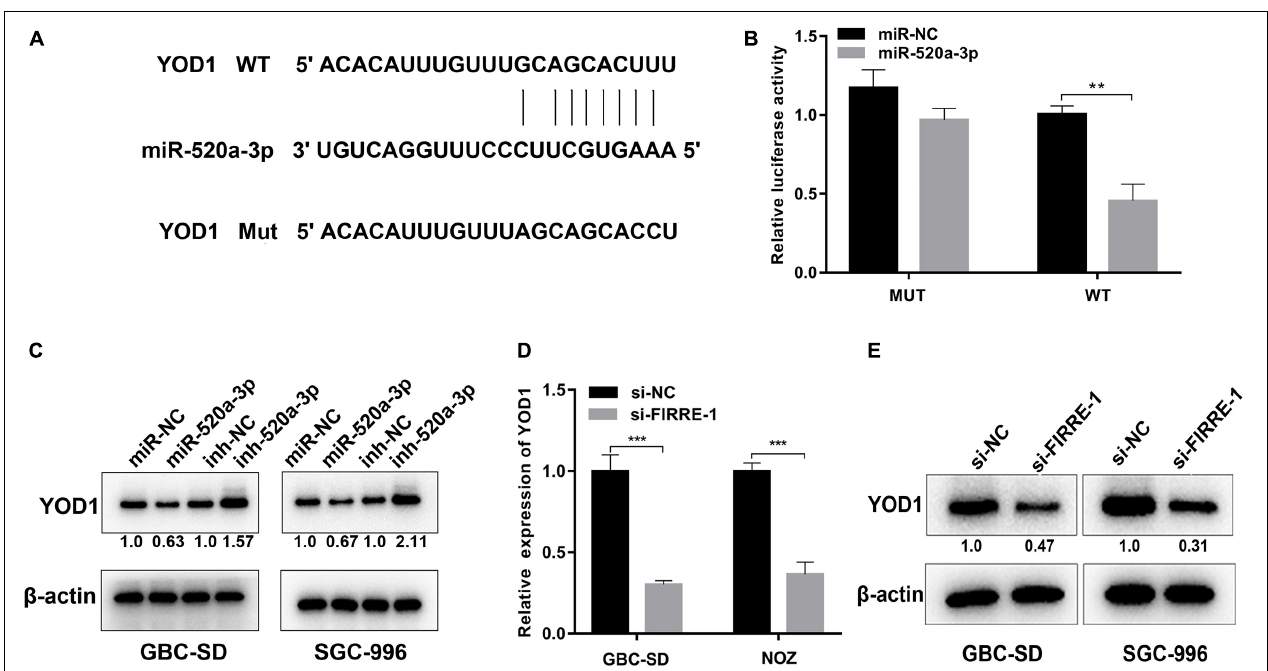
FIGURE 6 | YOD1 is directly targeted by miR-520a-3p and indirectly regulated by FIRRE. (A) The 3 (cid:48) -UTR of YOD1 mRNA contains wild-type or mutant miR-30a-5p-binding sequences. (B) The relative luciferase activities were detected in 293 T cells after transfected with YOD1 3 (cid:48) UTR-WT or YOD1 3 (cid:48) UTR-Mut and miR-NC and miR-520a-3p, respectively. (C) Relative mRNA and protein levels of YOD1 were detected in GBC cells after transfection with miR-NC, miR-520-3p, inh-NC, and inh-520a-3p using qRT-PCR and western blot, respectively. (D,E) Relative expression levels of YOD1 was detected by qRT-PCR and western blot in cells transfected with si-NC or si-FIRRE-1. ** P < 0.01, *** P <